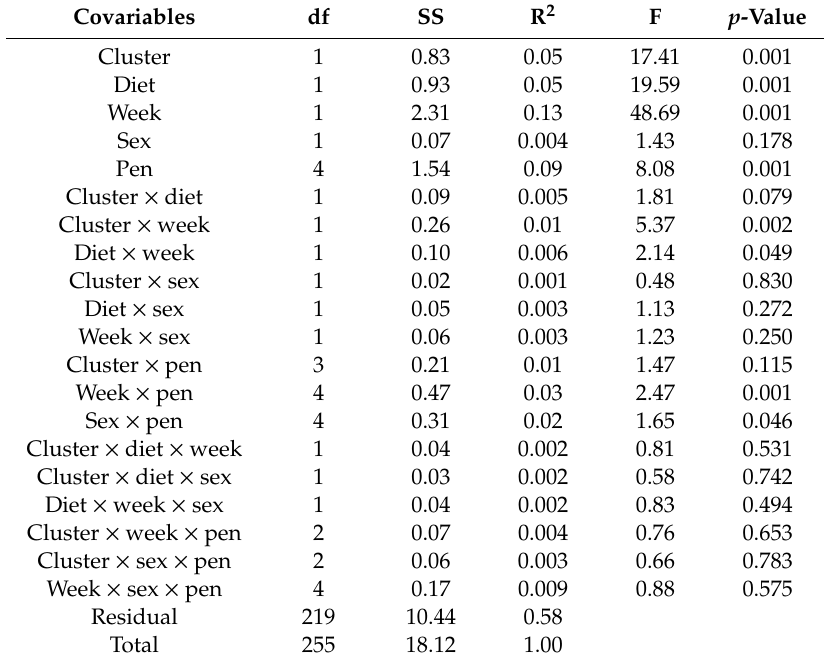
Table 3. Permutational multivariate analysis of variance (PERMANOVA) results for fecal communities of pigs fed diets with or without phytase 1